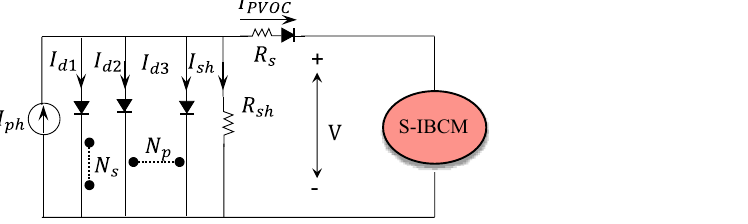
Figure 1. The structure of the HMG.